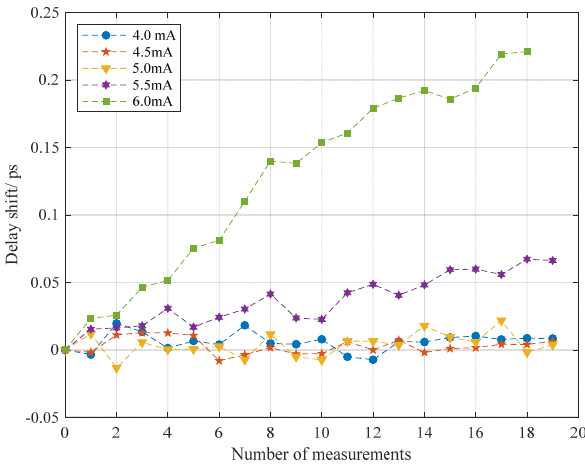
Figure 8. Cumulative delay shift varied with the number of discharges for different currents.